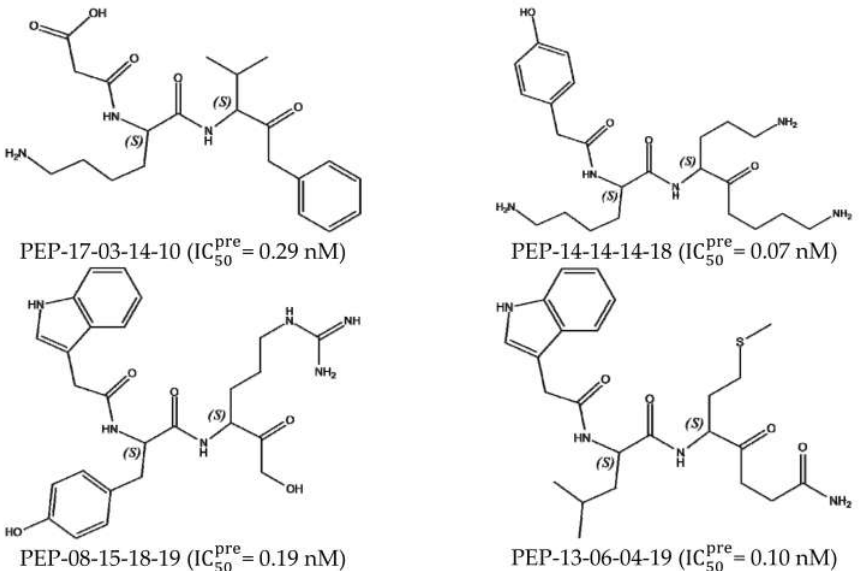
Figure 7. Chemical structures towards Pf FP3 of four most potent PEP analogues.